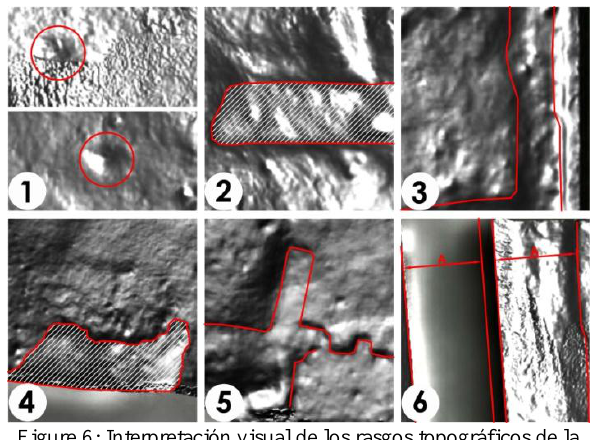
Figure 6: Interpretación visual de los rasgos topográficos de la ruina del Castillo de Villagarcía de